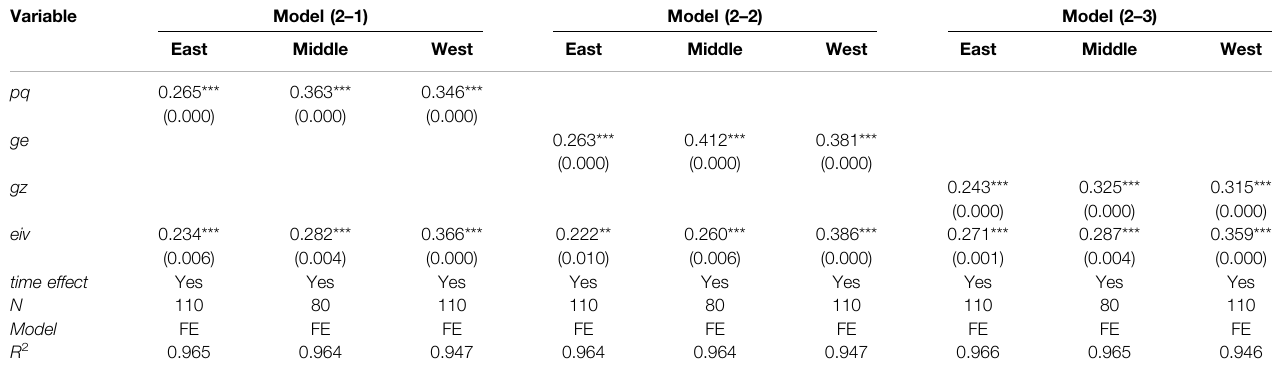
TABLE 8 | Baseline results of Model (2).